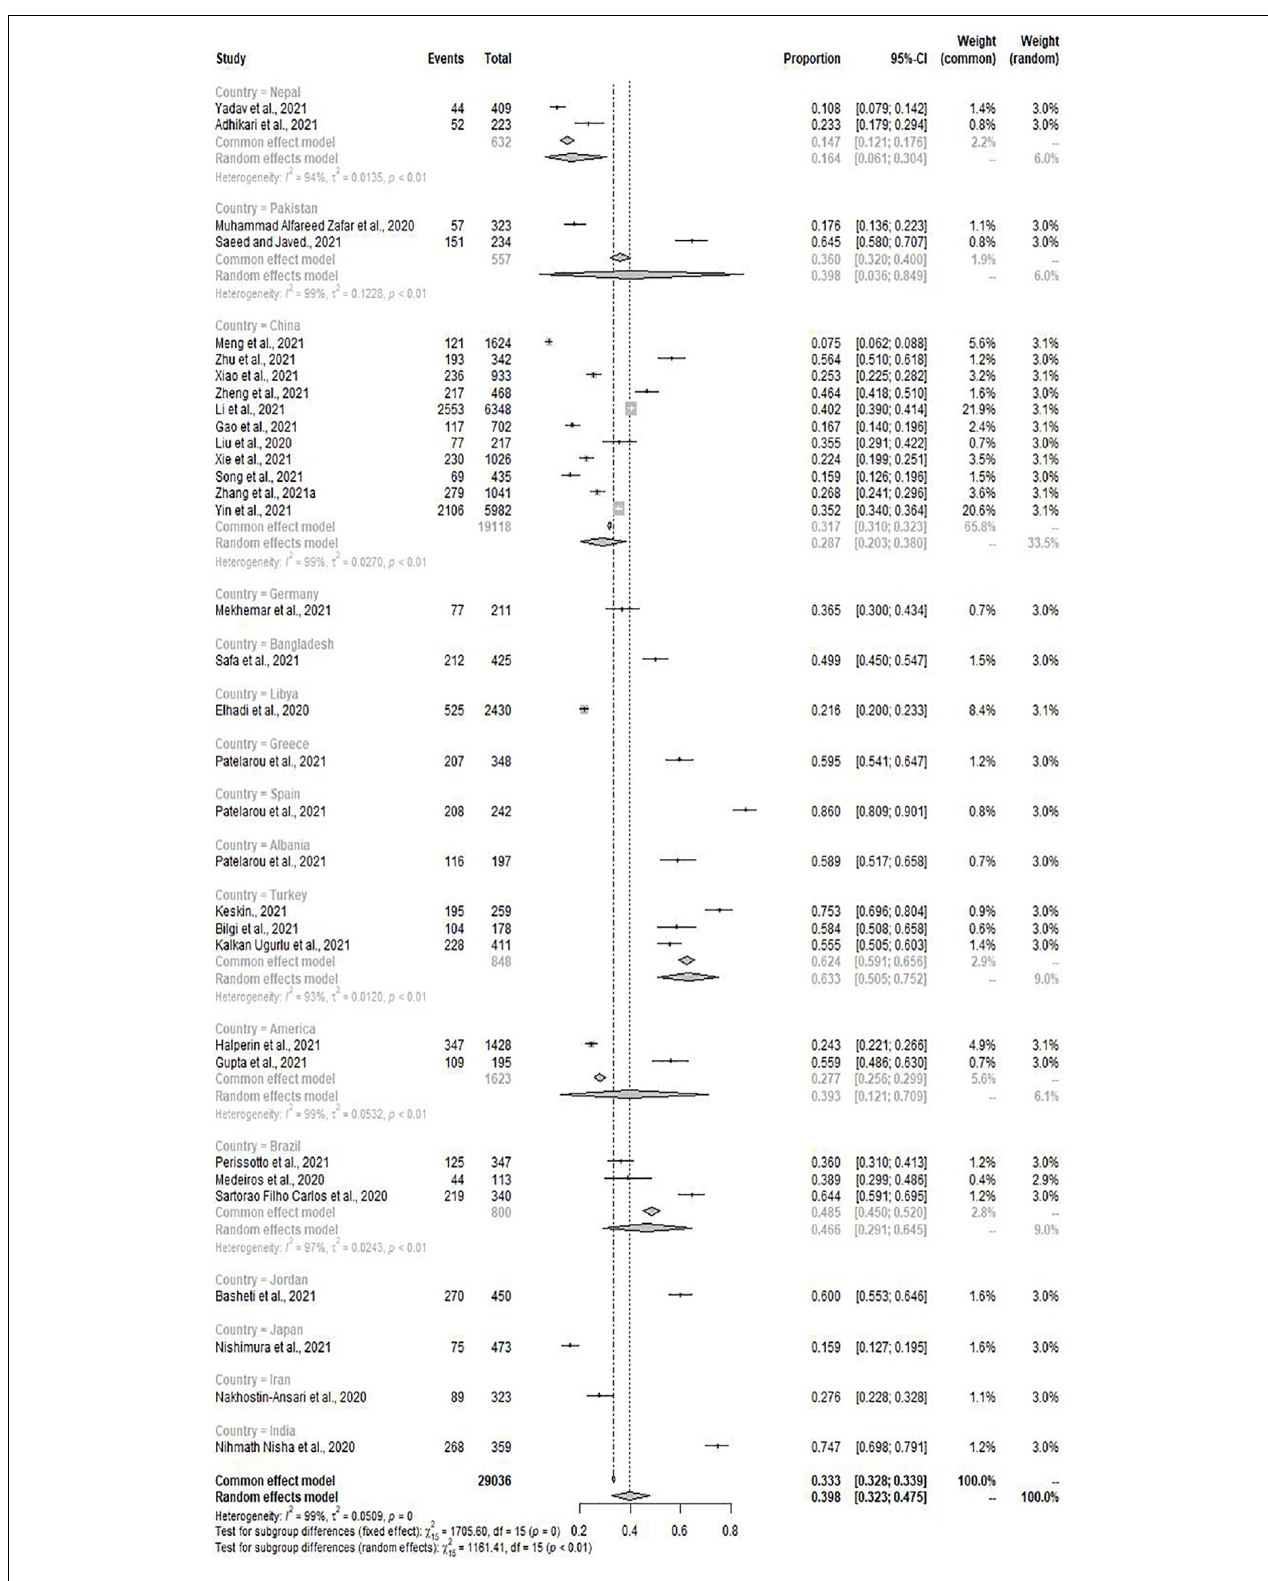
FIGURE 4 | Subgroup analysis by countries for